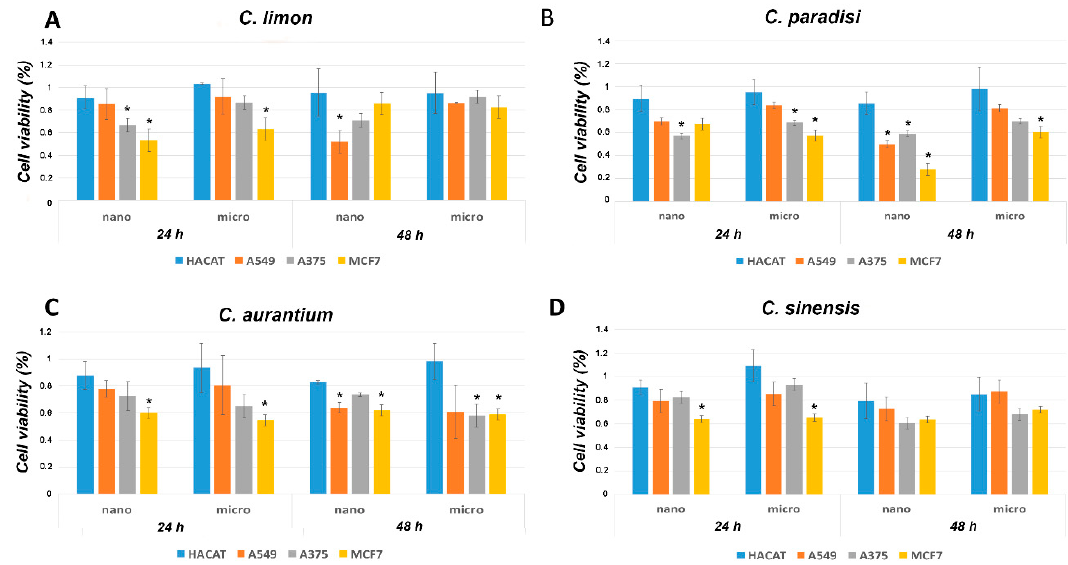
Figure 1. Citrus-derived nano and microvesicles reduce cancer cell proliferation. Cell growth was measured by MTT assay after 24 h and 48 h incubation with 25 µ g / mL (expressed in protein content) of nano- and microvesicles isolated from the fruit juices of the following Citrus species: ( A ) C. limon, ( B ) C. paradisi , ( C ) C aurantium and ( D ) C. sinensis . The values were plotted as fold changes concerning related mock-treated cells (100% viable). Each point represents the mean ± SD of three independent experiments. Asterisks denote statistically significant values in comparison to non-tumour cells (HaCaT) assessed by t -test (* p ≤ 0.05).